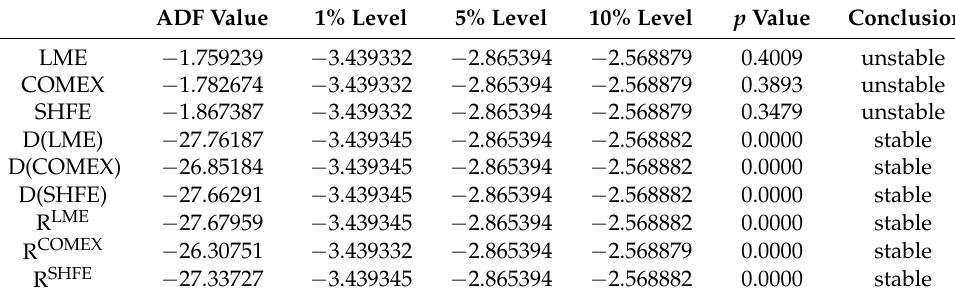
Table 3. Stationarity test of unit root ADF after the stock